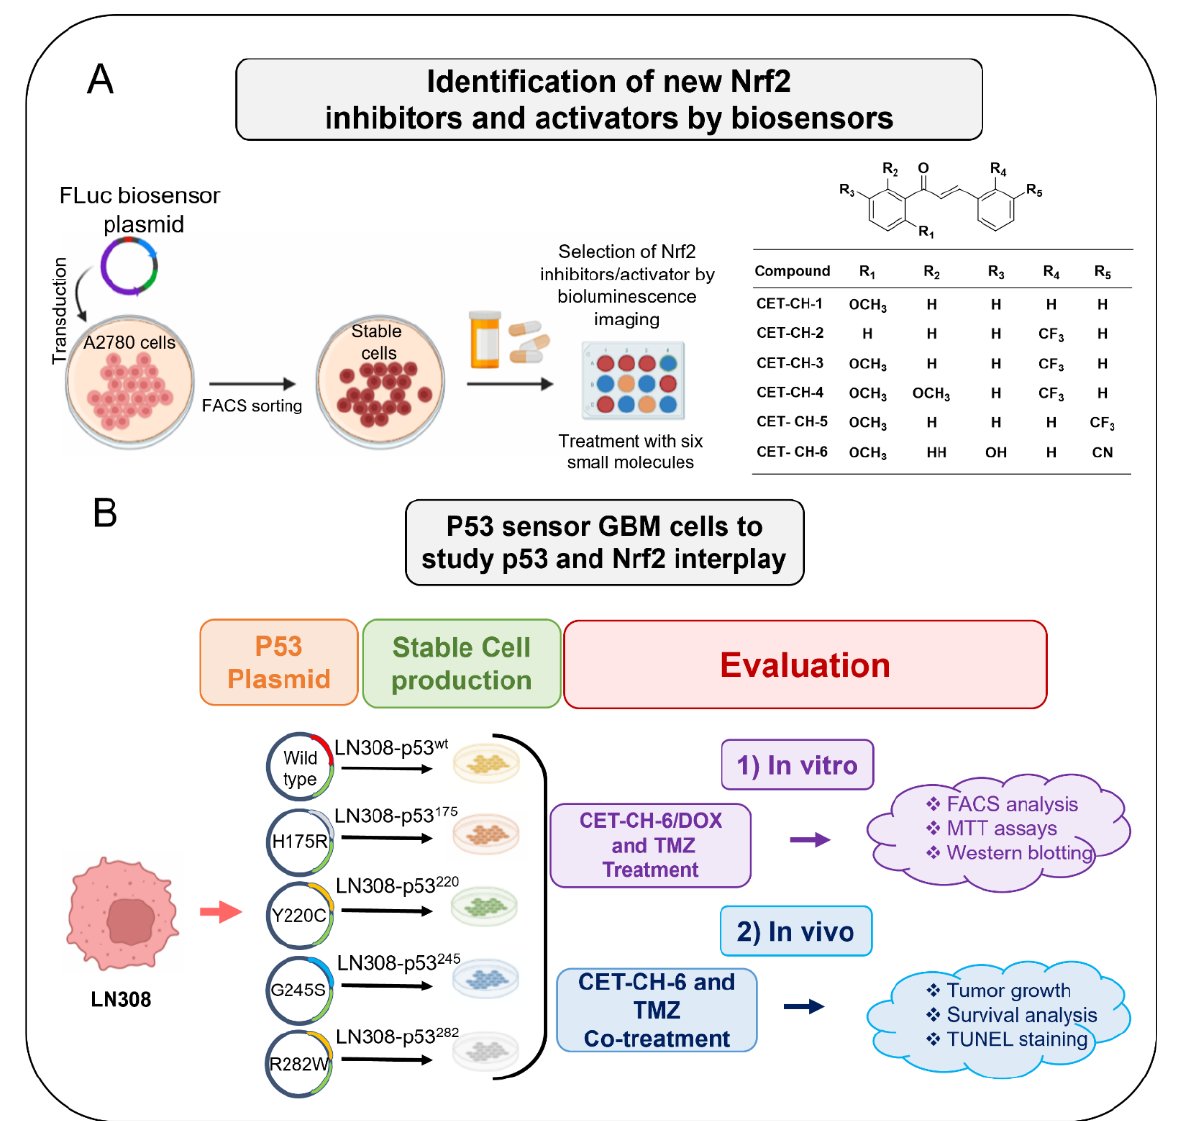
Figure 1. Schematic of study workflow. ( A ) A molecular imaging biosensor identifies Nrf2 inhibitors and activators from a set of small molecule compounds. A2780 cells were transduced by a construct that carries a Firefly luciferase reporter gene under an Nrf2 responsive target gene promoter, the NQO1. Upon activation of Nrf2, the FLuc signal is enhanced, while inhibition reduces the FLuc signal intensity; ( B ) evaluation of Nrf2-mediated mechanism in p53 wild-type and mutant cell lines in response to Nrf2 modulators. LN308 cell line with null-p53 were transduced with five different constructs containing mutant p53 and GFP. In each construct, the mutation was placed in the hotspot structural position in GBM. These cell lines as well as U87-MG with wild-type p53 were then evaluated for apoptotic populations and growth inhibition when co-treated with Nrf2 inhibitor compounds and chemotherapeutic drugs.